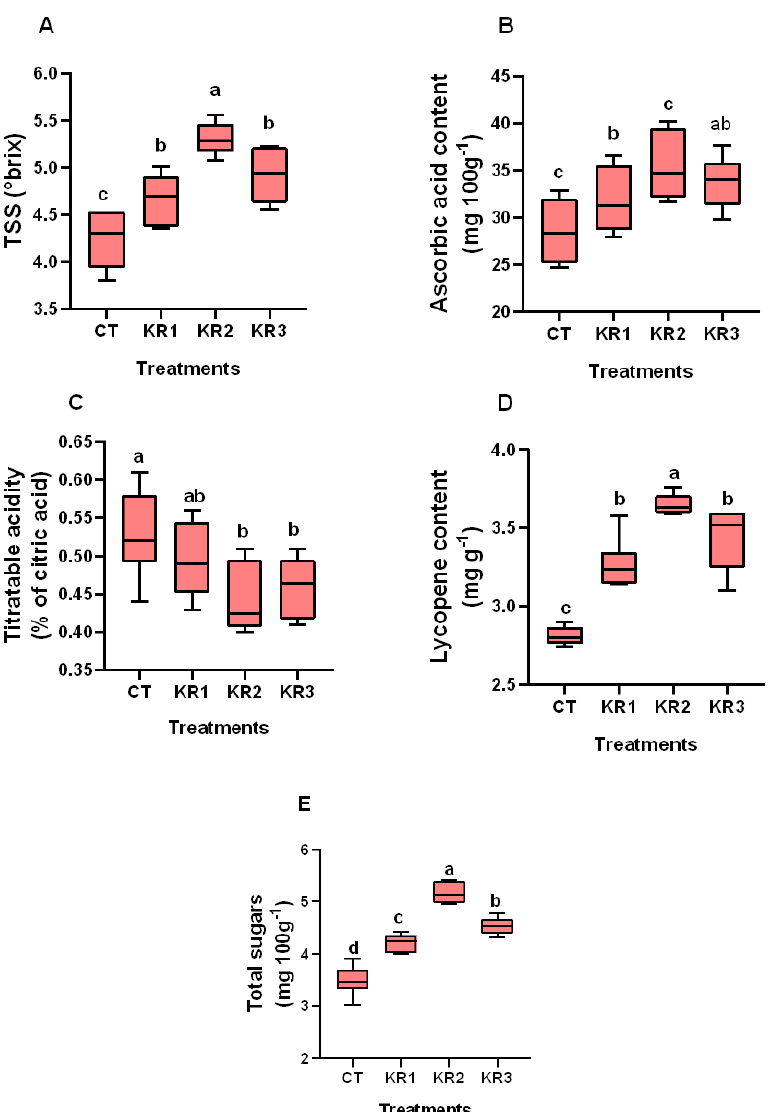
Figure 5. Quality parameters of tomato plants treated with Kendal Root biostimulant: ( A ) Total soluble solids; ( B ) ascorbic acid content; ( C ) titratable acidity; ( D ) lycopene; and ( E ) total sugars. Data in the figure are expressed as mean ± SE. Mean values followed by the same letter do not differ significantly at p ≤ 0.05 by DMRT.